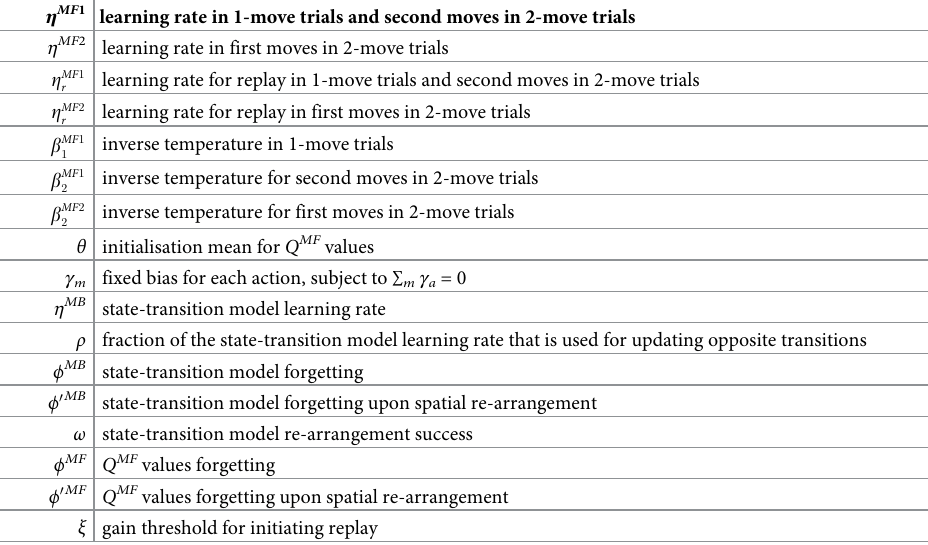
Table 1. Free parameters of the